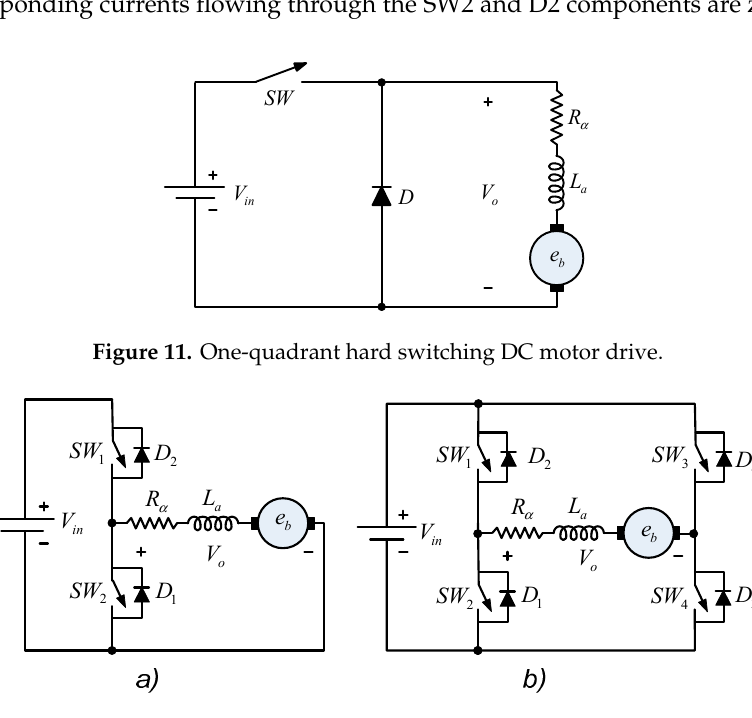
Figure 12. ( a ) Two-quadrant and ( b ) Four-quadrant hard-switching DC motor drives .